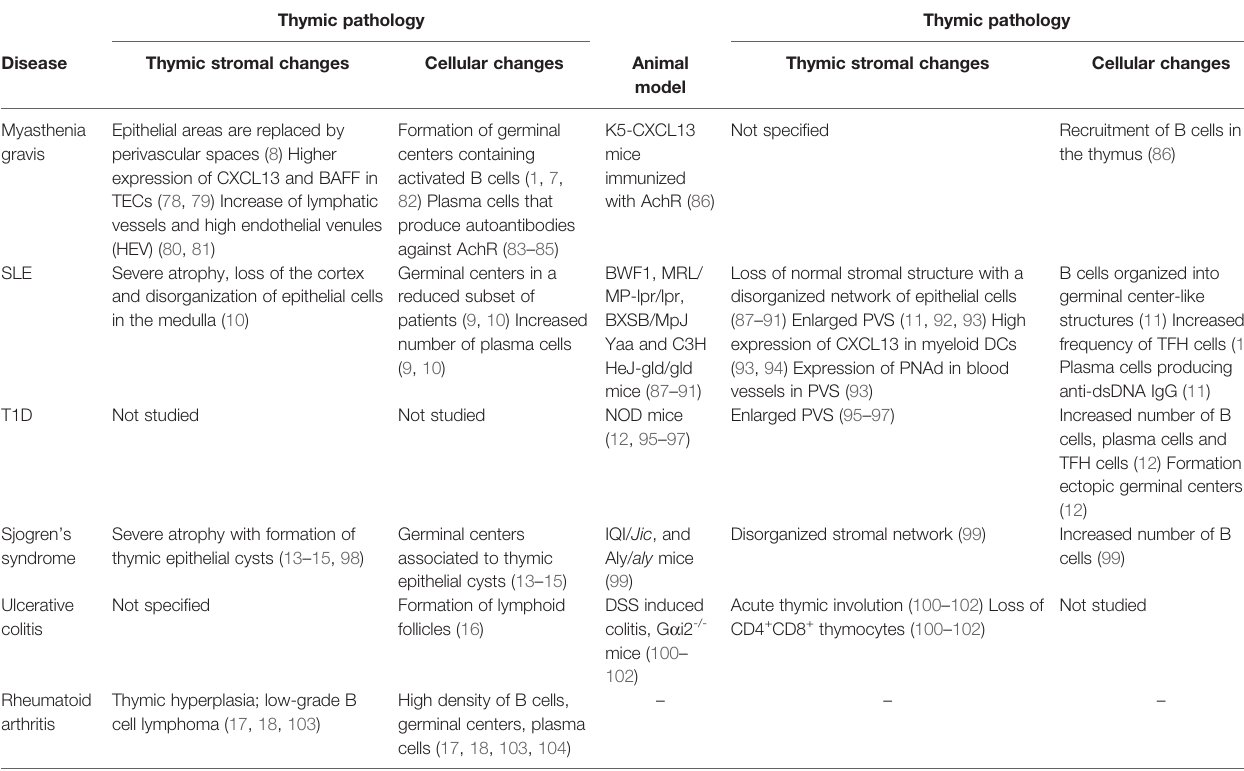
TABLE 1 | Various autoimmune disease and relevant animal models that are associated with thymic